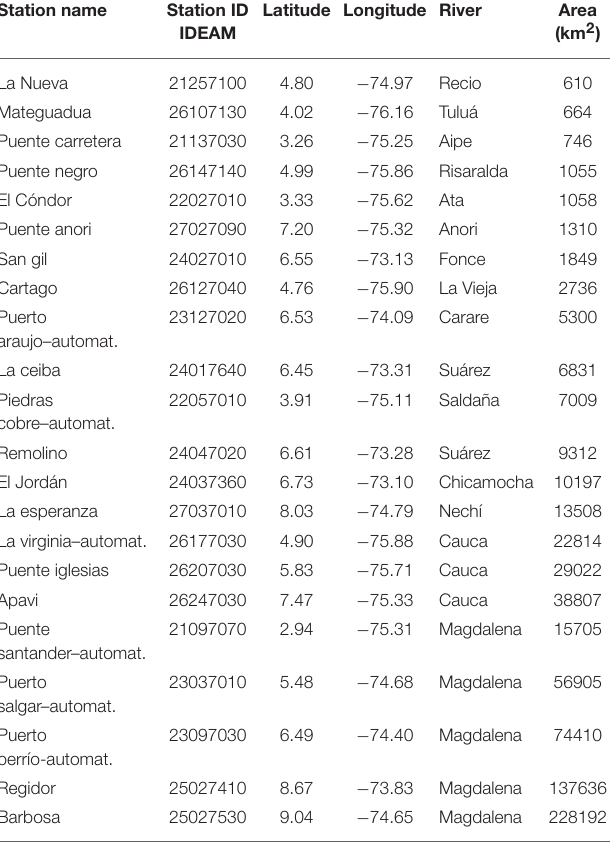
TABLE 3 | Discharge stations used for validation. TABLE 4 | List of variables and parameters used in the precipitation downscaling